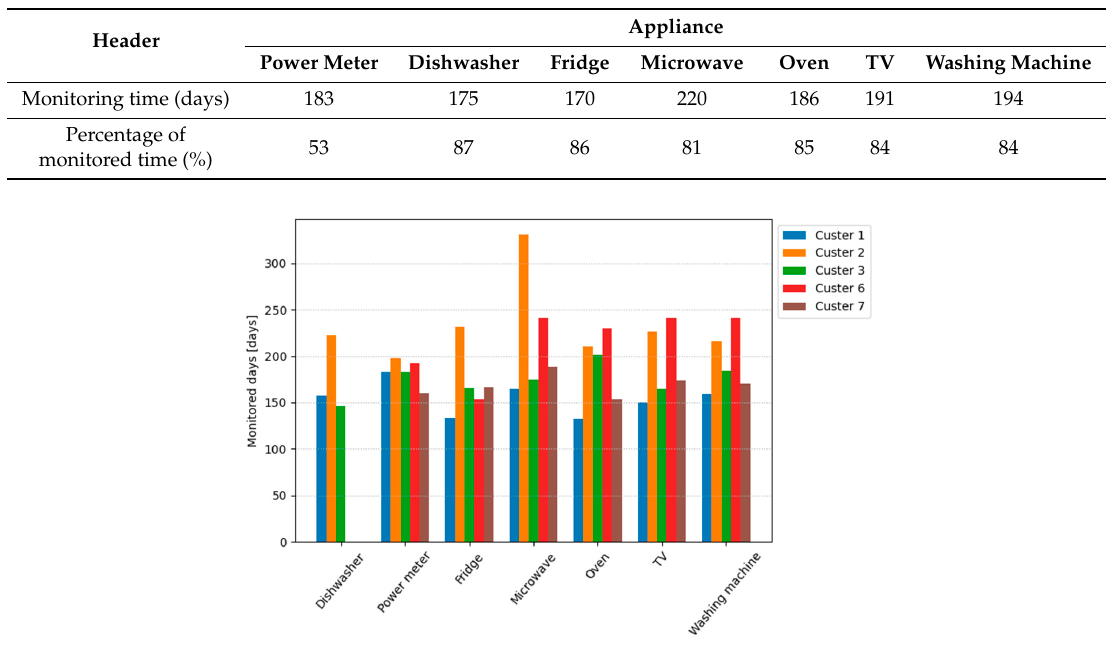
Table 6. Average monitoring time by appliance.